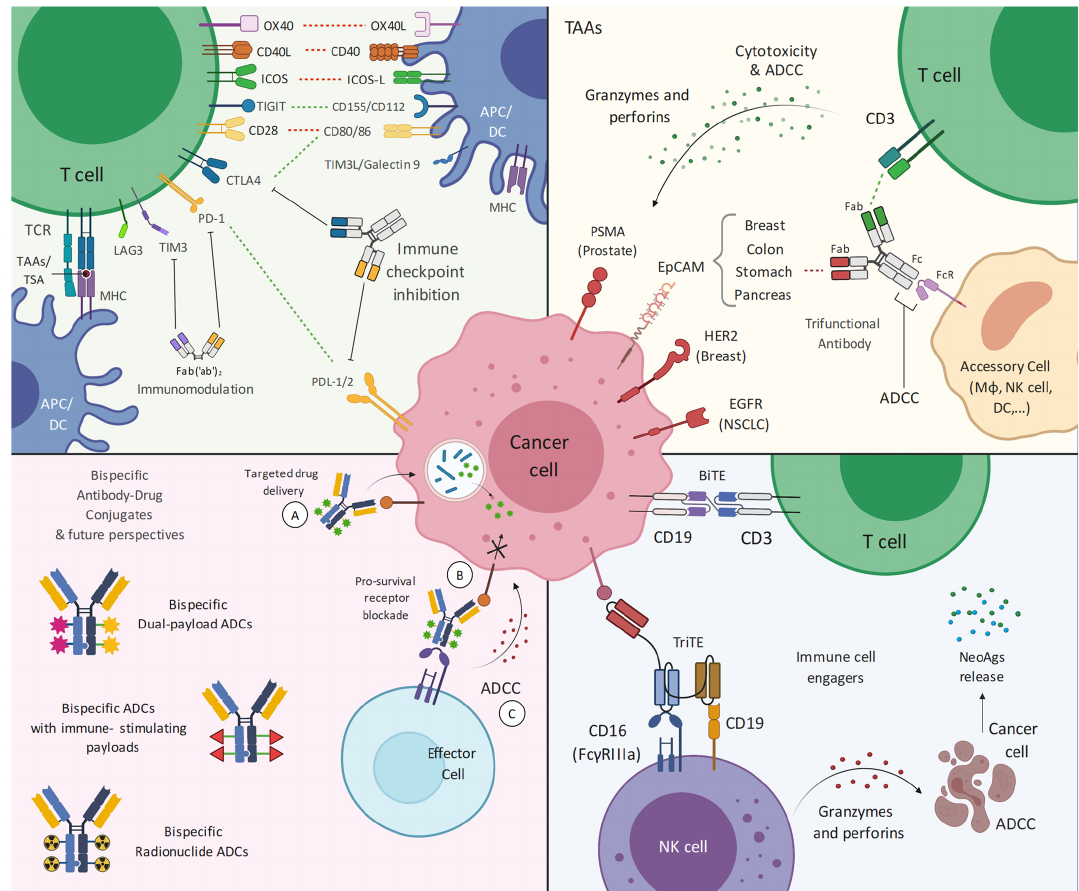
Figure 1. Main design, applications, and future perspectives of bispecific antibodies and engagers. Each quadrant represents different applications of bi- and tri-specific novel technologies. Upper left panel : dual immune checkpoint blockade by means of bispecific antibodies or nanobodies. Co-targeting of multiple co-stimulatory molecules has been exploited either to enhance immune checkpoint inhibition or to combine immune checkpoint blockade and immunomodulation. Red-dashed lines: co-stimulatory molecules; green-dashed lines: co-inhibitory molecules. Upper right panel : bispecific antibodies targeting dual tumor-associated antigens. Trifunctional properties of bsAbs comprise an appropriate Fc region in order to not only recruit T-cells, but also accessory cells bearing activating Fc γ R. Hence, additional T-cell-activating signals and presentation of tumor-derived antigens to T-cells can be provided; Lower left panel : bispecific antibody-drug conjugates are investigational strategies aiming at exploiting both the target-specific properties of engineered antibodies and the cytotoxic activity of payloads; Lower right panel : most immune cell engagers are trans-binding bispecific antibodies (bsAbs) usually consisting of two linked single-chain fragment variables (scFvs) that originate from different monoclonal antibodies: one scFv recognizes a surface TAA, whereas the other is specific for a certain membrane molecule expressed on effector immune cells. Abbreviations: OX40, Tumor necrosis factor receptor superfamily, member 4 or TNFRSF4; OX40L, OX40 ligand; ICOS, Inducible costimulator; ICOS-L, Inducible costimulator-ligand (ICOS-L); CD, cluster of differentiation; TIGIT, T cell immunoreceptor with Ig and ITIM domains; TIM3, T-cell immunoglobulin mucin 3; TIM3L, T-cell immunoglobulin mucin 3 ligand; CTLA-4, Cytotoxic T-Lymphocyte Antigen 4; PD-L1, Programmed death-ligand 1; PD-1, Programmed Death 1; TCR, T-cell receptor; LAG3, Lymphocyte-activation gene 3; MHC, Major Histocompatibility Complex; TAA, tumor- associated antigen; TSA, tumor-specific antigen; Fab, antigen-binding fragment; Fc, fragment crystallizable region; FcR, fragment crystallizable region receptor; APC, antigen-presenting cell; DC, dendritic cell; ADC, antibody-drug conjugates; ADCC, antibody-dependent cytotoxicity; PSMA, prostate-specific membrane antigen; BiTE, Bi-specific T-cell engager; TriTE, trispecific T-cell engager; EpCAM, Epithelial cell adhesion molecule; HER2, Human Epidermal Growth Factor Receptor 2; NK, natural killer cell; NeoAgs; neoantigens; Fc γ RIIIA, Fc Gamma Receptor IIIa; M ϕ , macrophage; NSCLC, non-small cell lung cancer. Created with